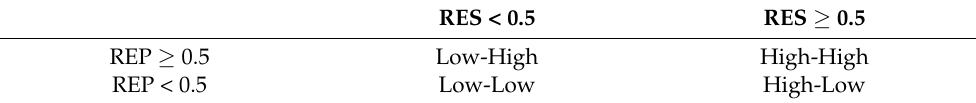
Table 3. The coupling mechanism of the RES index and REP